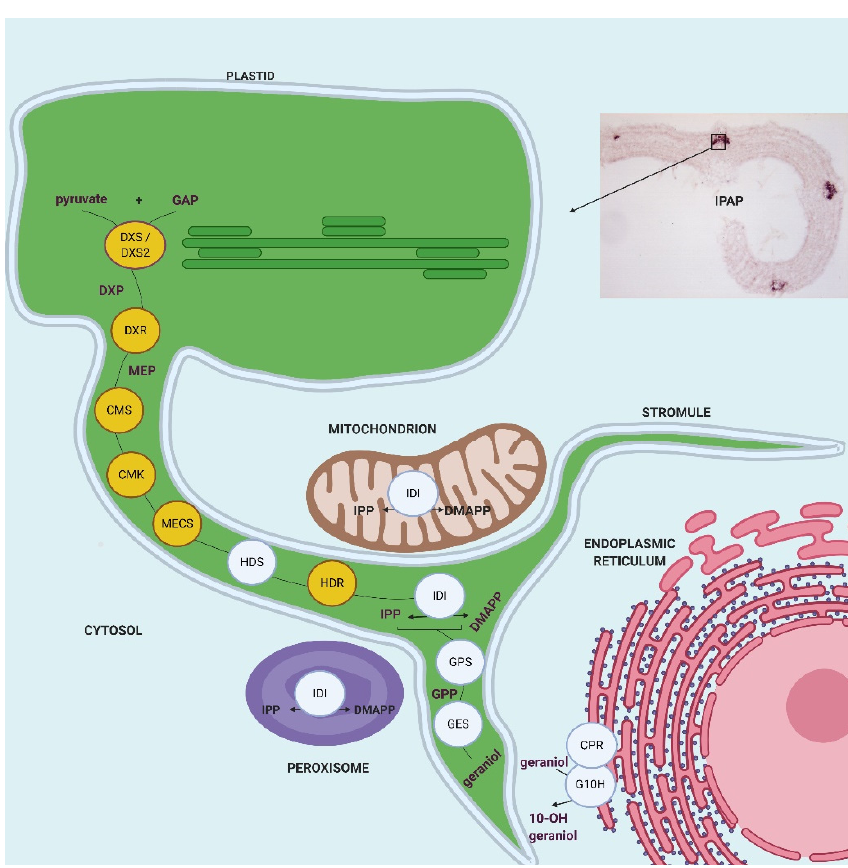
Figure 12. Schematic representation of the cellular and subcellular organization of the MEP pathway and early stage of the monoterpene seco-iridoid (MSI) pathway in C. roseus leaves. The enzymes characterized in this study are highlighted in yellow. IDI (type I IPP isomerase) displayed a triple subcellular targeting in stroma / stromules of plastids, mitochondria and peroxisomes as established [34]. The proximity between stromules and the endoplasmic reticulum facilitates export of geraniol in the close environment of G10H to increase hydroxylation rate. DXS, 1-deoxy-D-xylulose 5-phosphate synthase; DXR, 1-deoxy-D-xylulose 5-phosphate reductoisomerase; CMS, 2- C -methyl-D-erythritol 4-phosphate synthase; CMK, 4-(cytidine 5 ′ diphospho)-2- C -methyl-D-erythritol kinase; MECS, 2- C -methyl-D-erythritol 2,4-cyclodiphosphate synthase; HDS, ( E )-4-hydroxy-3-methylbut-2-enyl diphosphate synthase; HDR, ( E )-4-hydroxy-3-methylbut-2-enyl diphosphate reductase; IDI, isopentenyl diphosphate isomerase. GPS, geranyl diphosphate synthase. GES, geraniol synthase. CPR, cytochrome P450 reductase. G10H, geraniol 10-hydroxylase. IPAP, internal phloem associated parenchyma. GAP, glyceraldehyde 3-phosphate. DXP, 1-deoxy-D-xylulose 5-phosphate. MEP, 2-C-methyl-D-erythritol 4-phosphate. IPP, isopentenyl diphosphate. DMAPP, dimethylallyl diphosphate. GPP, geranyl diphosphate. Created with Biorender.com.